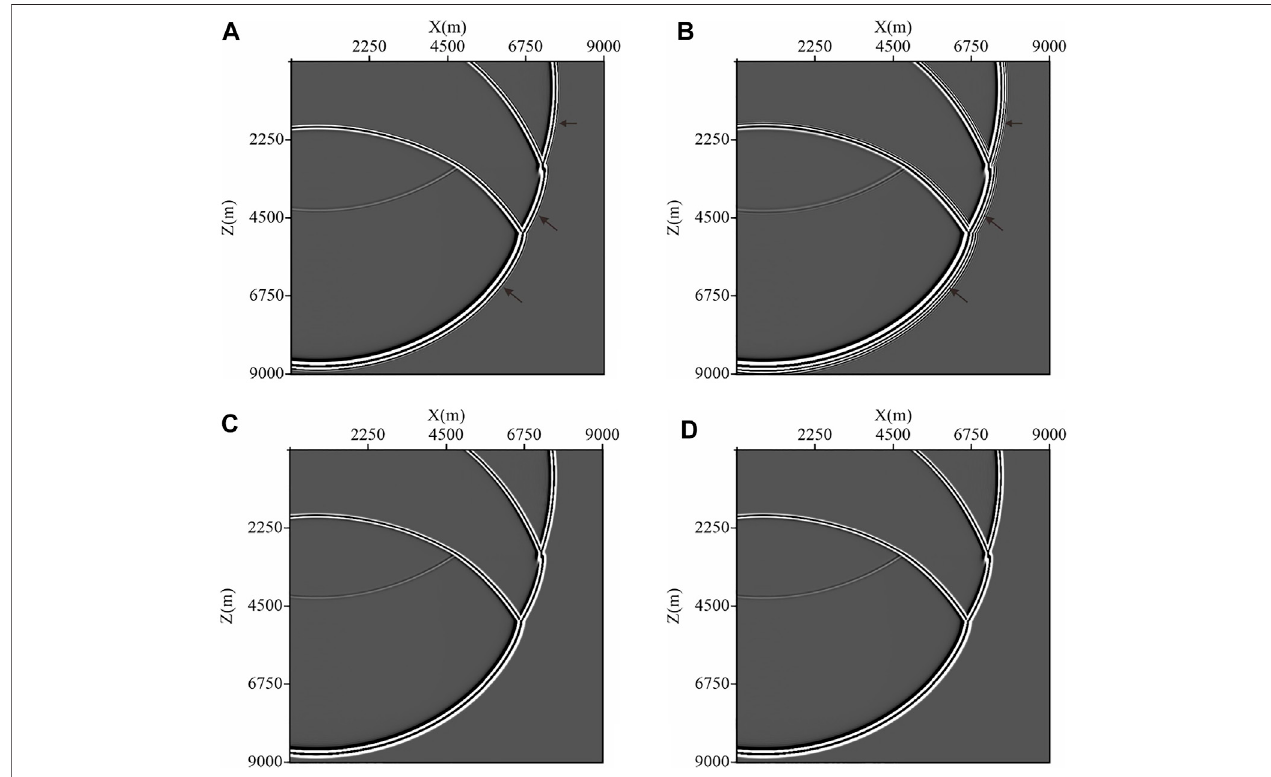
FIGURE7| Acousticsnapshotsat3.0sforthethree-layeredmodel. (A,B) C-SFD( M =10)withthetimestep Δ t (cid:2) 1 . 0msand Δ t (cid:2) 1 . 5ms. (C)(D) M-SFD( M =8; N =1) with time step Δ t (cid:2) 1 . 0ms and Δ t (cid:2) 1 . 5ms.